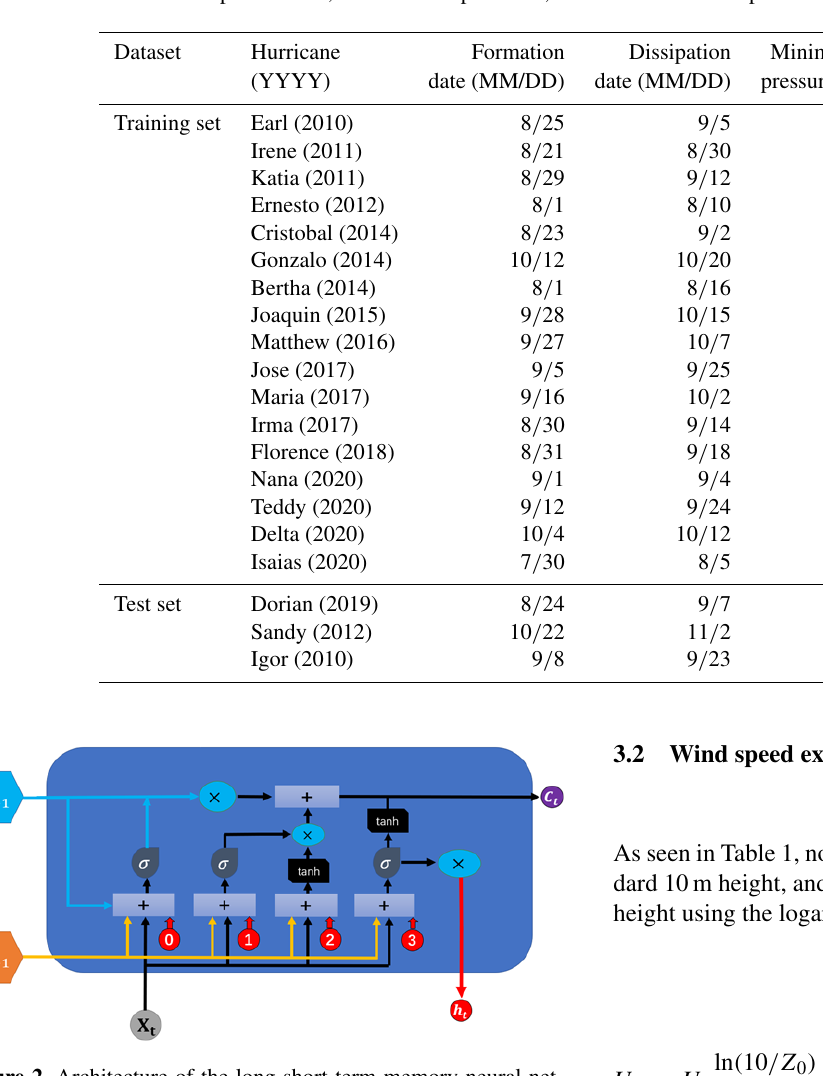
Figure 2. Architecture of the long short-term memory neural net- work